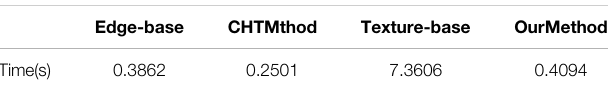
TABLE 6 | Comparison of running